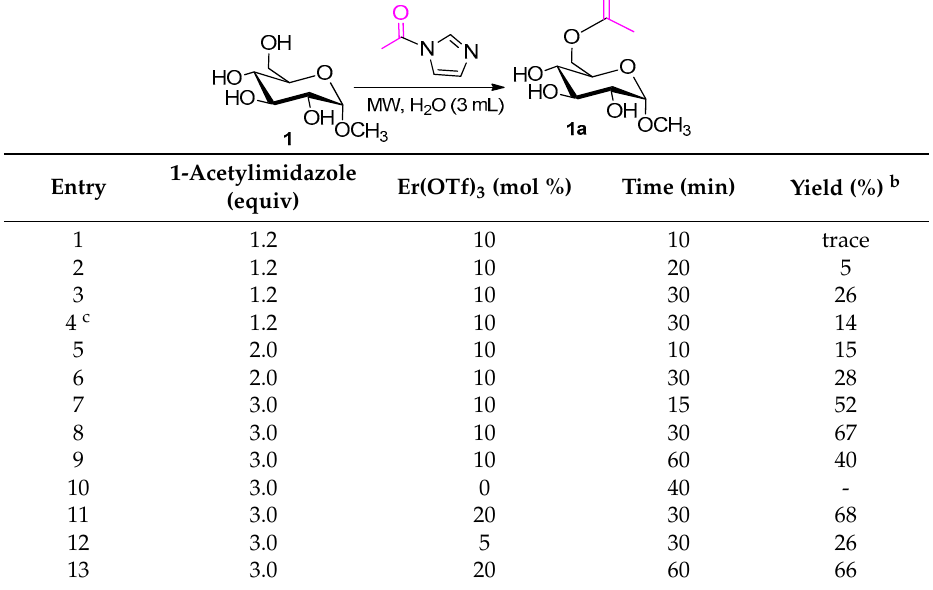
1-Acetylimidazole Er(OTf) 3 (mol %) Time (min) Yield (%) b Entry 1 ‐ Acetylimidazole (equiv) Entry Er(OTf) 3 (mol %) Time (min) (equiv) 1